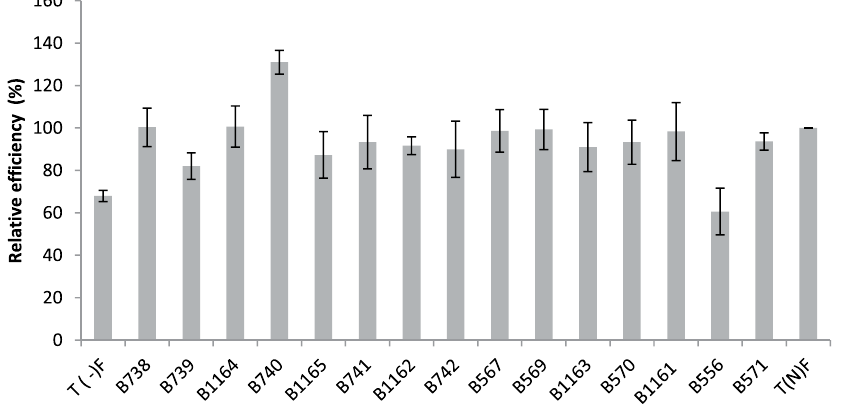
Fig. 5. Relative efficiency of the nodulating strains isolated from Fez and its regions. All data represent the mean ± SD of 3 replicates.